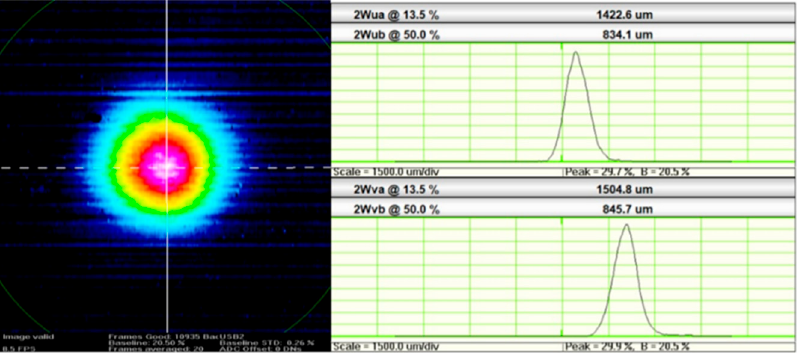
Figure 9. Image of a collimated output beam emitted by the constructed fiber laser.